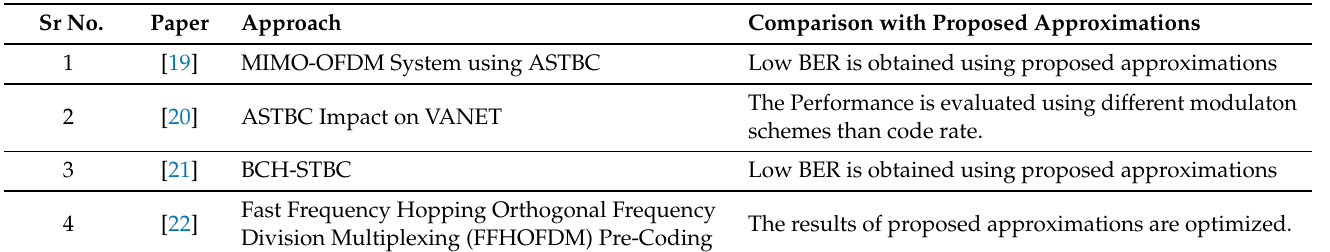
Table 4. ASTBC and VANET BER computation approaches.